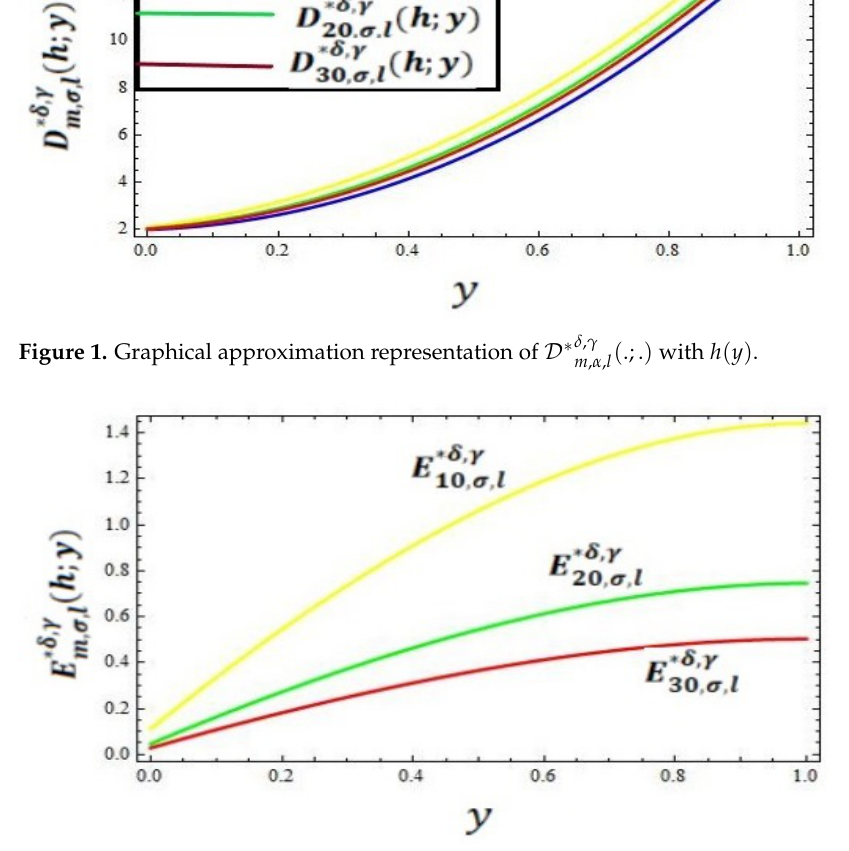
Figure 2. Graphical representation of